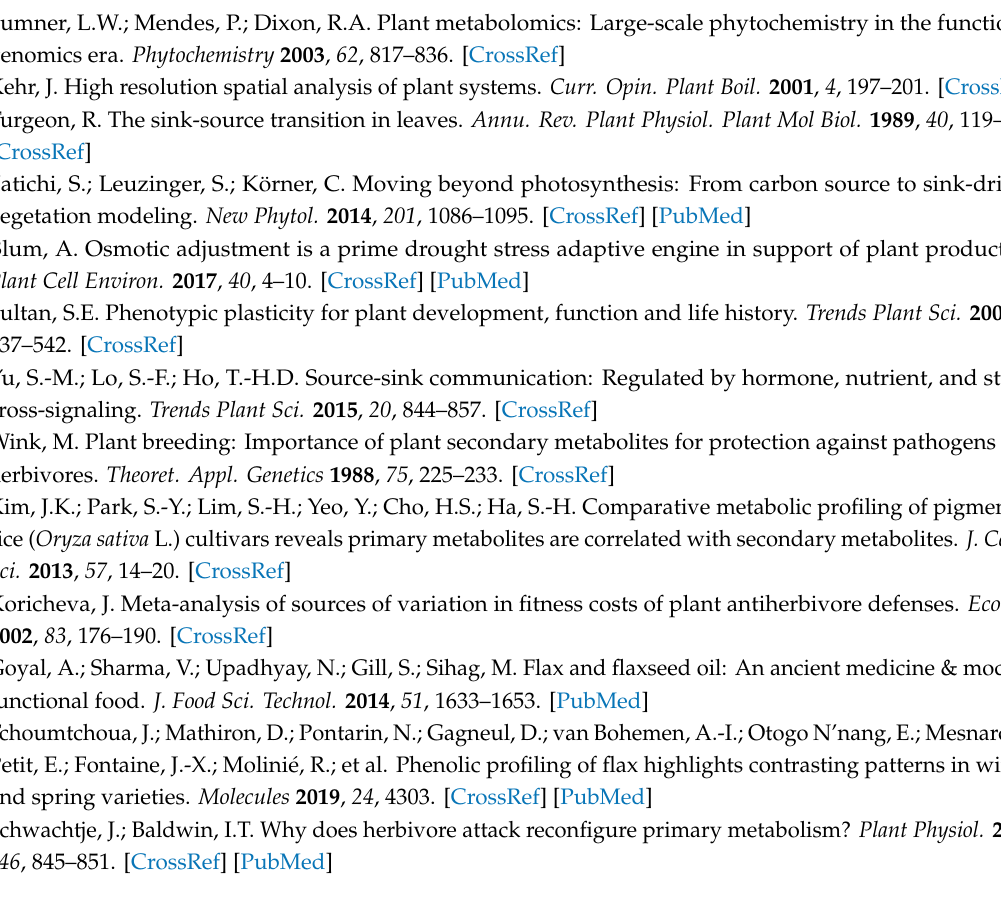
Figure S1: Withdrawal of flax leaves; Figure S2: Metabolite content of flax leaves; Figure S3: Inference of dry weight and leaf surface values of leaves that could not be withdrawn at day 0; Figure S4: Representative chromatogram and a detailed protocol for GC-MS analysis; Figure S5: Representative chromatogram and a detailed protocol for LC-MS